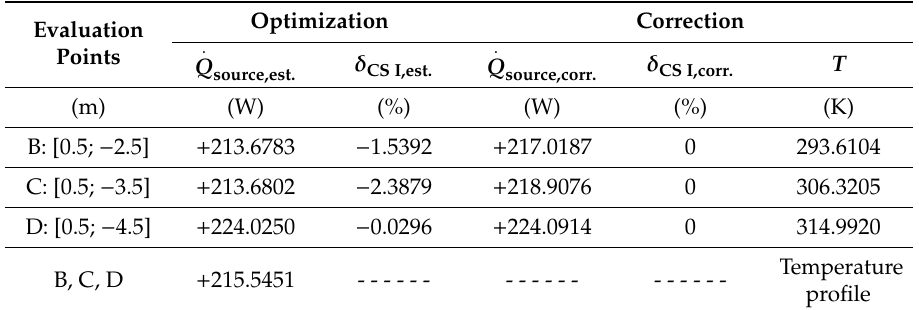
Table 5. The case study I: Estimation of the positive heat source . Q source,corr. to thermodynamic temperatures T B , T C , and T D and for evaluation points B, C, and D (for points and a thermal